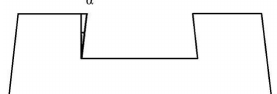
Figure 6. Crooked angle.